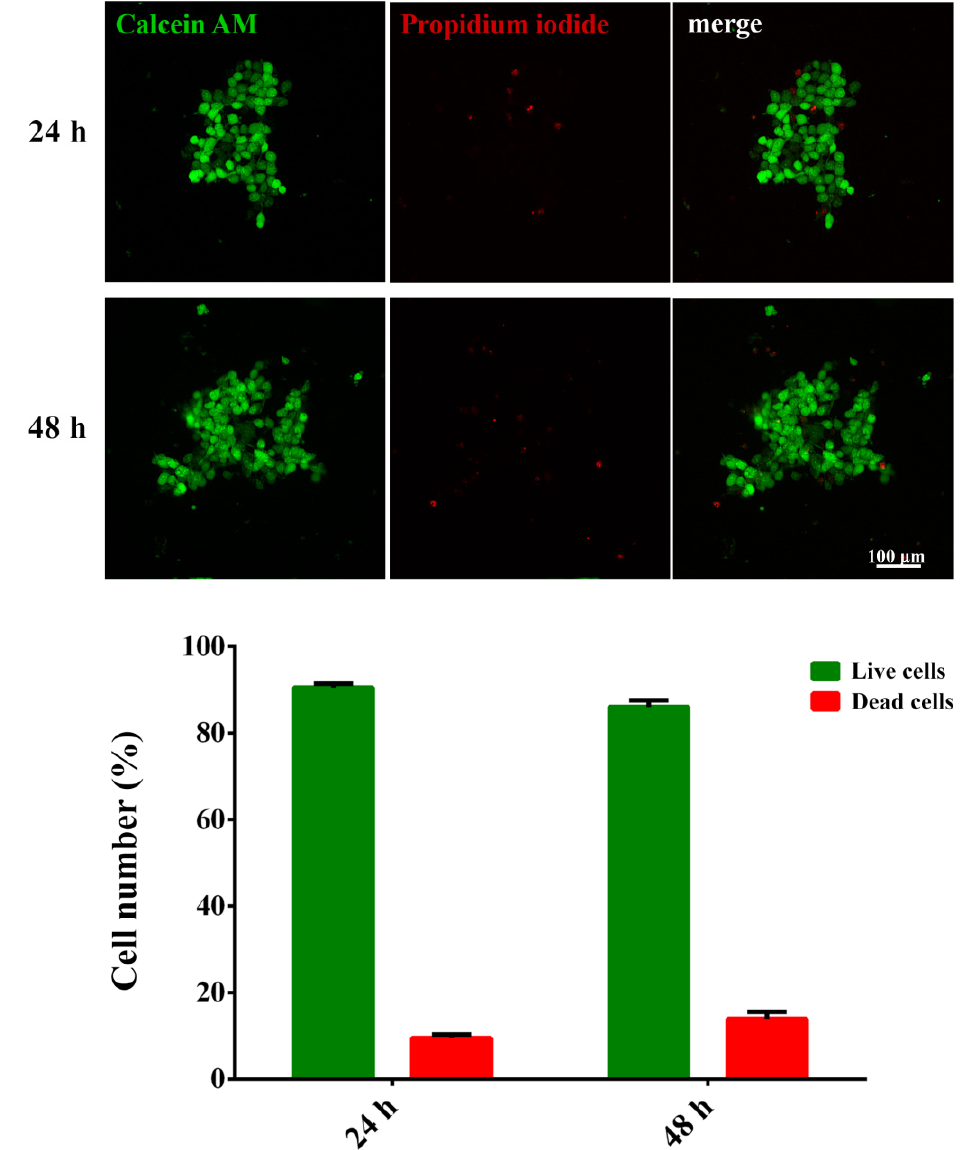
Figure 2. Viability of SW480 cells in the bacterial nanocellulose scaffold. Representative images and quantification of Calcein AM-labeled ( live ) and Propidium iodide-labeled ( dead ) cells in the scaffold 24 h or 48 h after the scaffold addition. The average number of live/dead cells per field was analyzed. Data are presented as mean ± SD.